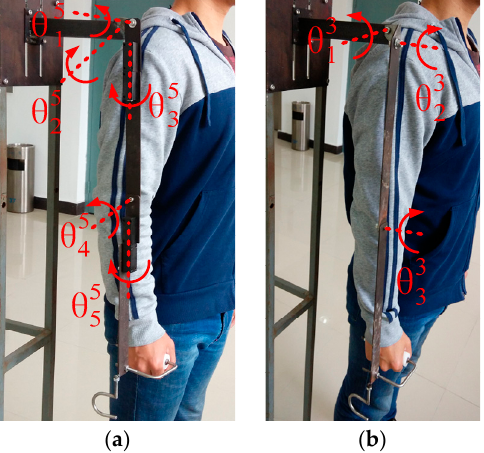
Figure 18. Manufactured exoskeleton prototype: ( a ) 5 ‐ DOF; and ( b ) 3 ‐ DOF.